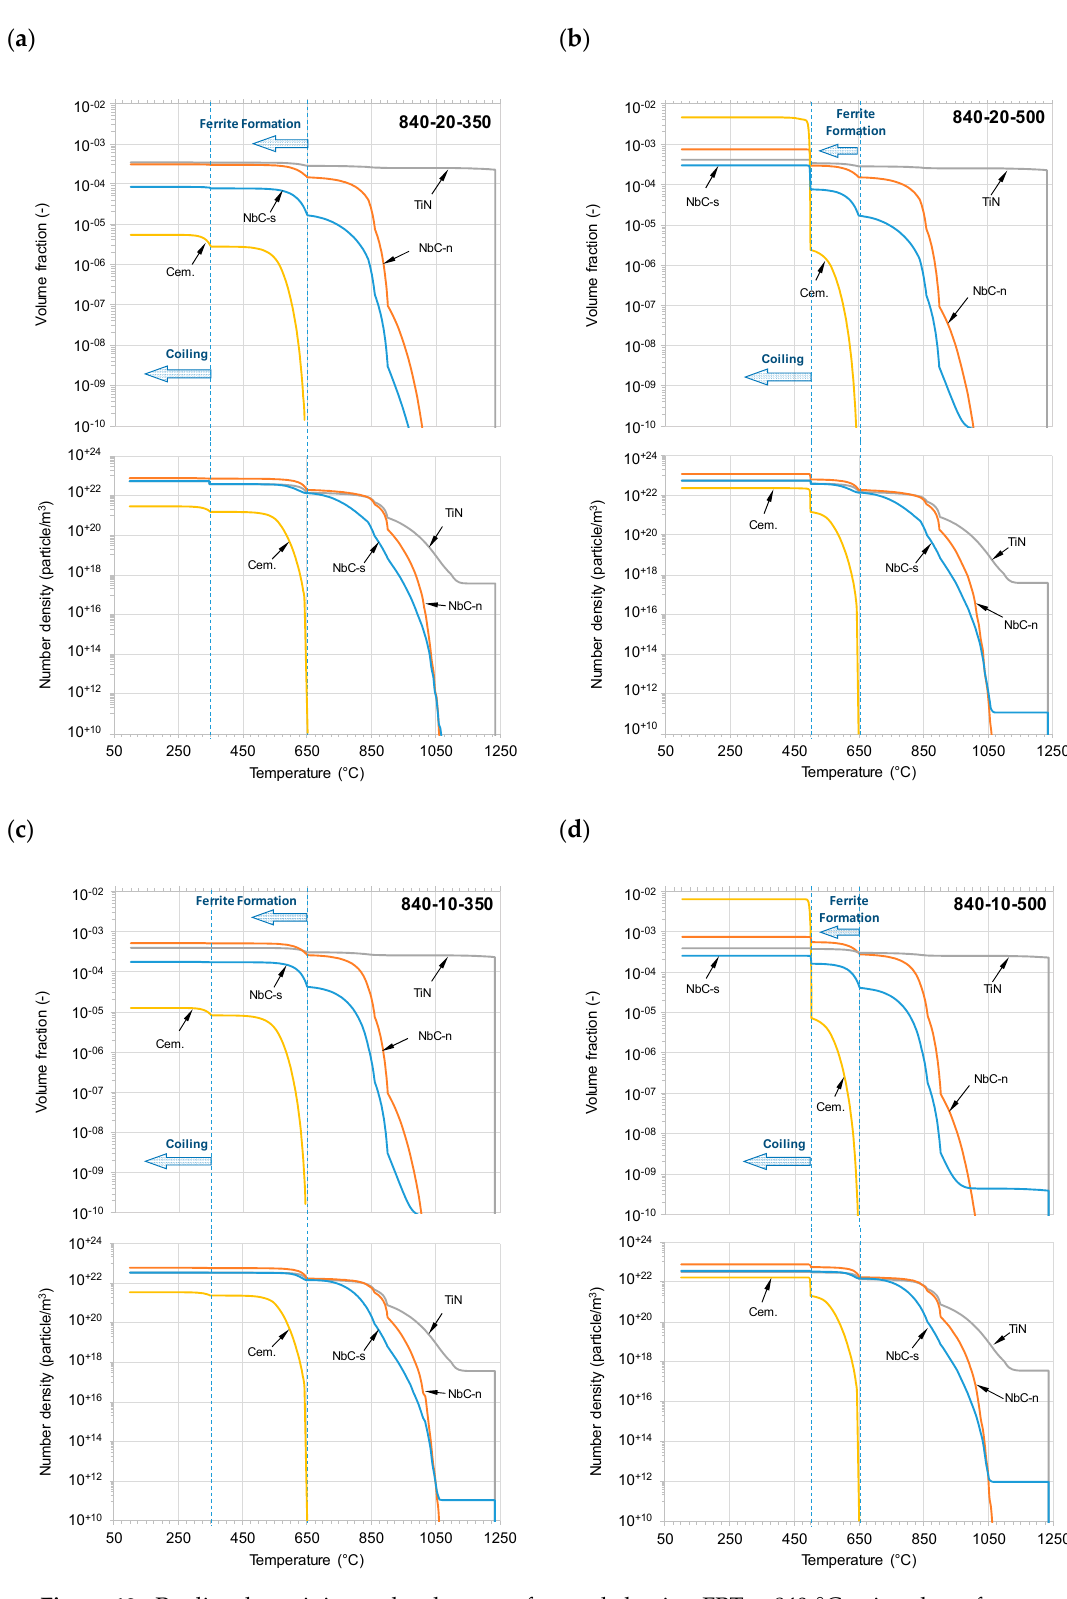
Figure 10. Predicted precipitates development for steels having FRT = 840 °C using the software MatCalc ® and applying the parameters ( a ) 20 K·s − 1 -350 °C, ( b ) 20 K·s − 1 -500 °C, ( c ) 10 K·s − 1 -350 °C and ( d ) 10 K·s − 1 -500 °C.